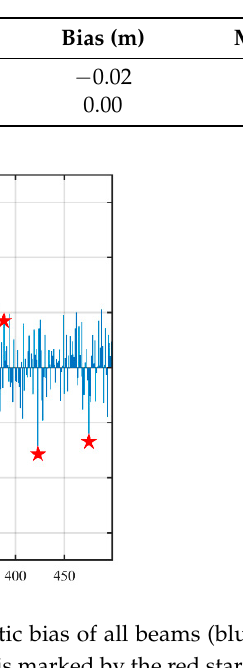
Table 3. Residuals of crossover differences before and after adjustment.